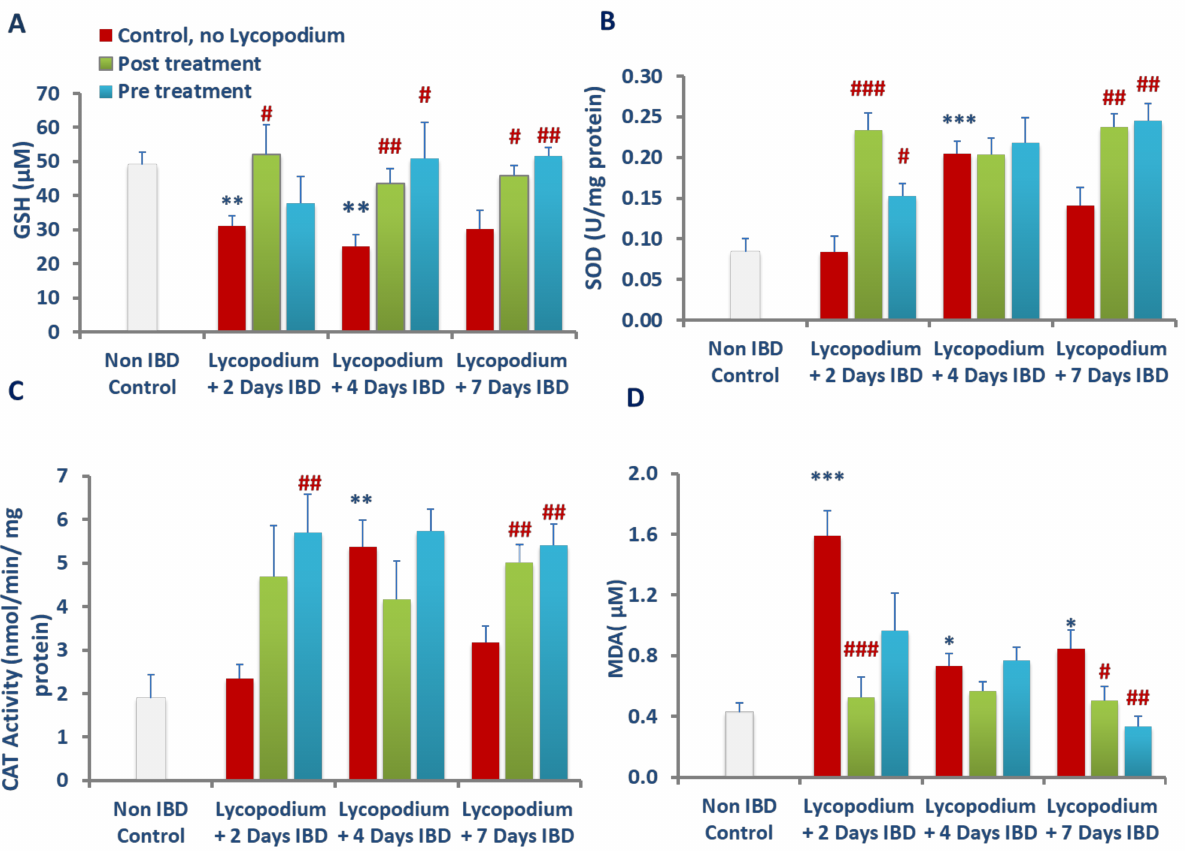
Figure 8. Effect of lycopodium on oxidative stress markers; GSH ( A ), SOD ( B ), Catalase ( C ) and MDA ( D ) in acetic acid-induced IBD in rats. Results are mean ± SEM; * p < 0.05, ** p < 0.01 *** p < 0.001 vs. non IBD control group; # p < 0.05, ## p < 0.01, ### p < 0.001 vs. relative IBD control